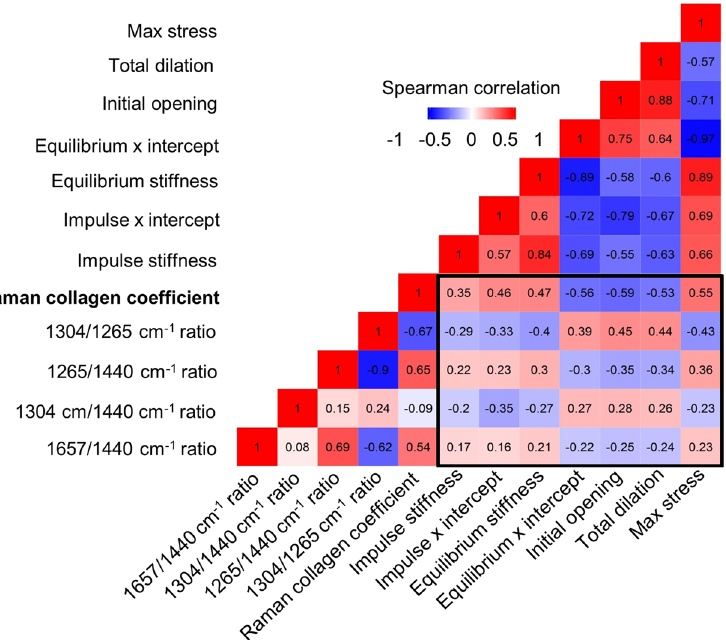
Figure 6. In vivo Raman data correlate with ex vivo biomechanical properties. Spearman correlation matrix containing four Raman peak ratios and a non-negative least squares component representative of collagen signatures for comparison to the impulse stiffness, impulse x intercept, equilibrium stiffness, equilibrium x intercept, initial opening, total dilation, and maximum stress measures obtained during biomechanical testing.